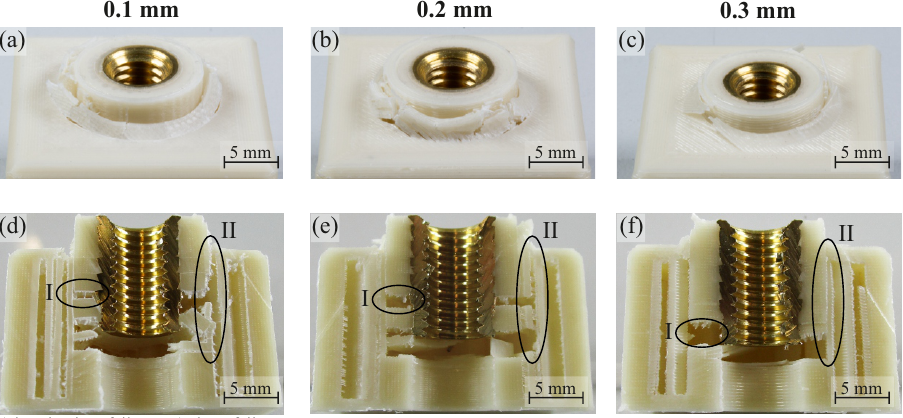
Figure 14. Exemplary test specimens of the test series with varying layer heights: top view ( a – c ) and sectional view ( d – f